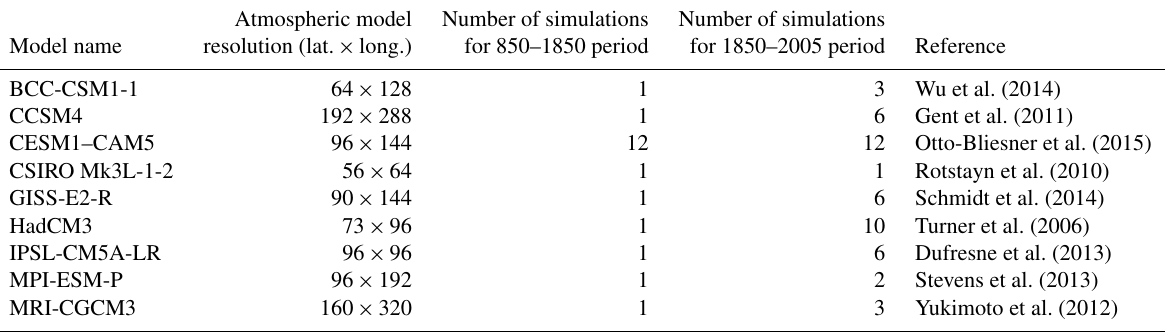
Table A1. PMIP3–CMIP5 GCM characteristics and